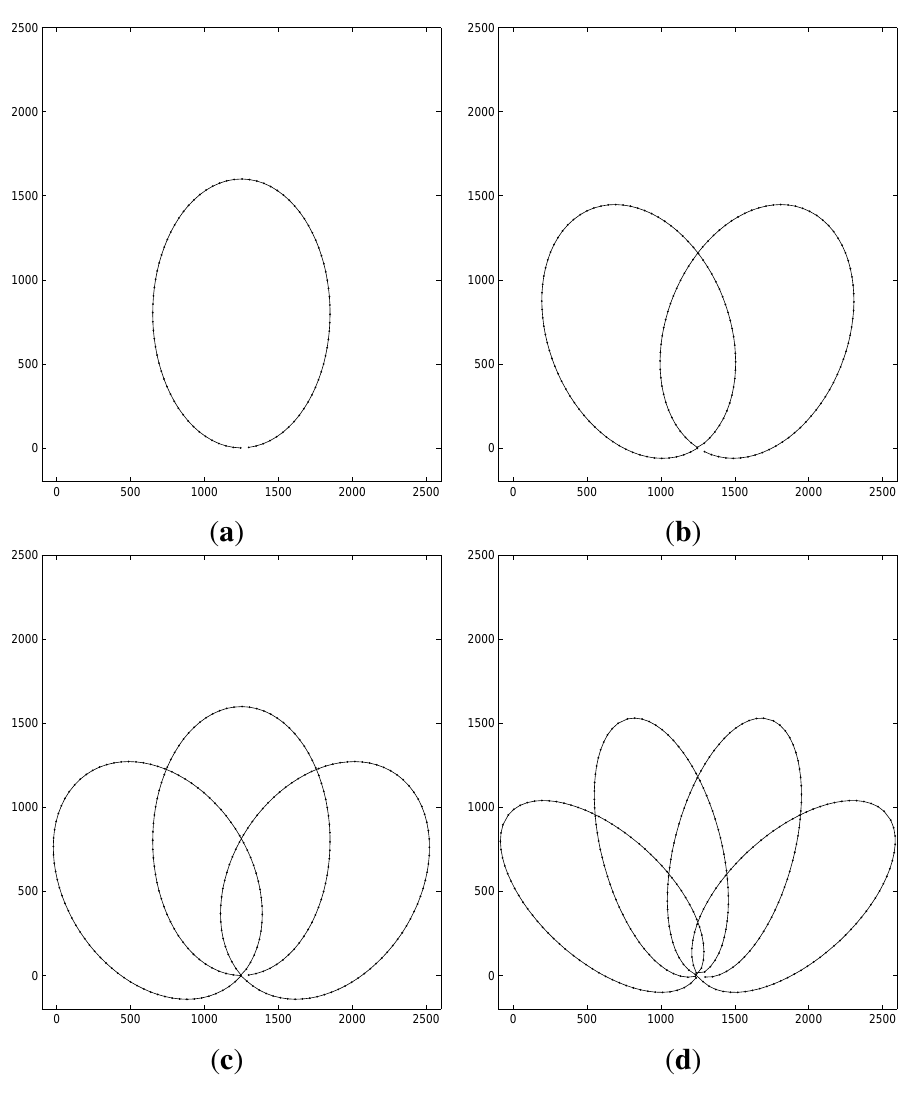
Figure 4. Trajectories of multiple